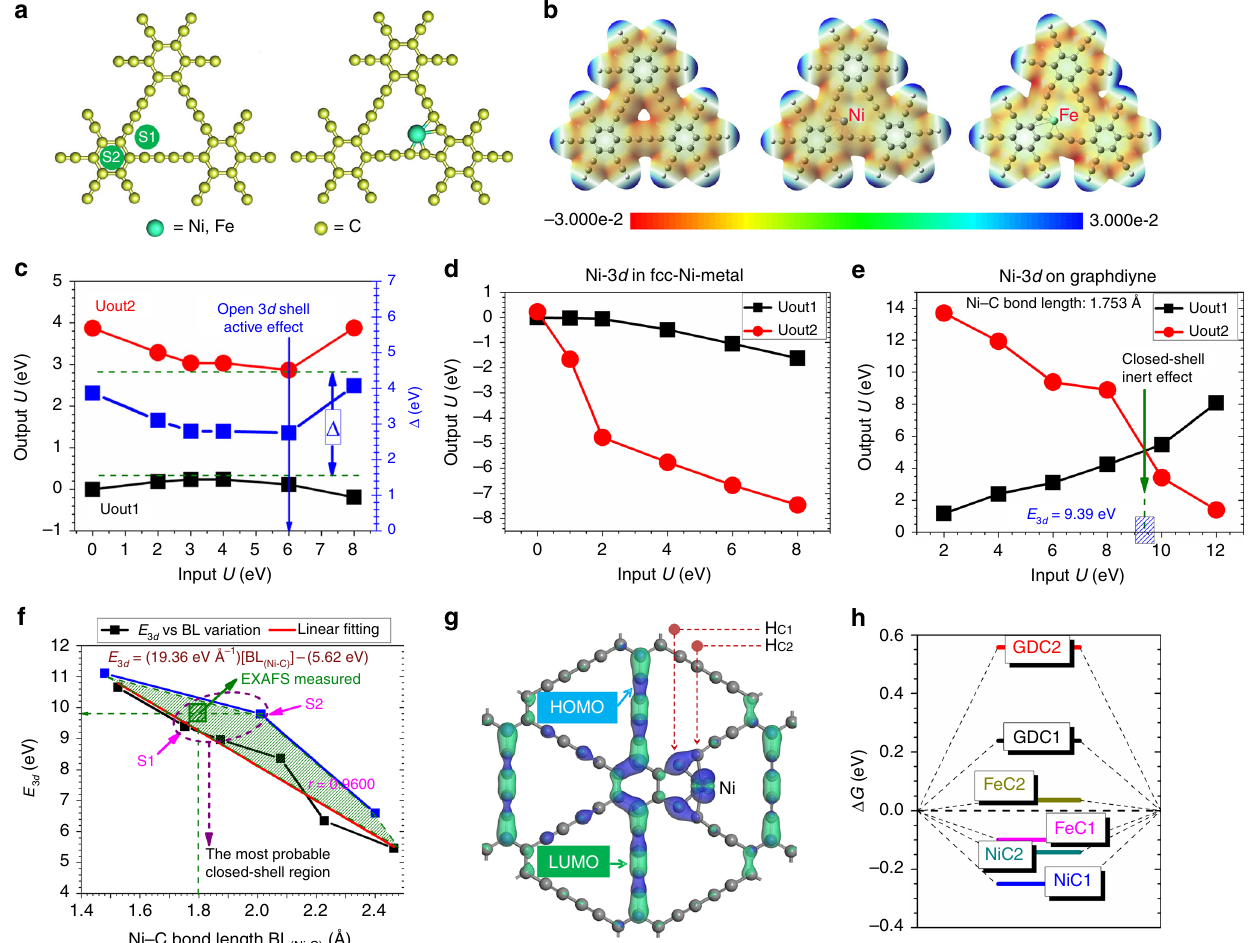
Fig. 4 Theoretical studies. a Adsorption of single metal atoms on GD (left: possible adsorption sites; right: optimized con fi guration). b Electrostatic potential maps of pristine GD, Ni/GD, and Fe/GD, respectively. The 3 d orbital energies for the targeted Ni site in c NiO, d Ni-on-GD, and e Ni-fcc are self- consistently determined via open- and closed-shell charge overlapping, respectively. f The variation of orbital energy variation with related to the newly formed Ni – C. The green shaded area denotes the Ni – C inter-distance-dependent Ni-closed-shell regions with related to Ni – C inter-distance. The purple dashed circle shows the most probable closed-shell orbital regions for Ni to be located on GD system in thermodynamic equilibrium state. The green square tells our experimental EXAFS measured data. g Real-space HOMO and LUMO contour plots on Ni-on-GD. The H C1 and H C2 denote the active H adsorption site on different C sites labeled with C1 and C2, respectively. h The chemisorption energy of H for HER performance with related to the free energy pro fi le ( Δ G ). The Ni/FeC1 and Ni/FeC2 mean the H adsorption on the C1 and C2 sites within Ni/Fe-on-GD system, respectively. The GDC1 and GDC2 denote the H adsorption on pristine